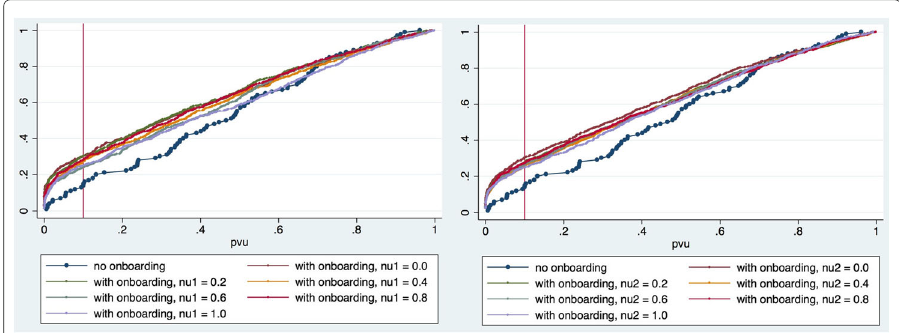
Fig. 6 Cumulate Density Functions of p -values returned by goodness-of-fit tests to the (best-fit) power-law models for in-degree distributions of the interaction networks in the control and treatment groups, for k > k min . Sixteen percent of the networks evolved without onboarding ( darkblue ) have degree distributions that test negatively for H2. When onboarding is introduced, that percentage rises to 25-30%. On the left figure, the treatment group interaction networks have been grouped according to the value taken by ν 1 ; on the right , they have been grouped according to the value taken by ν